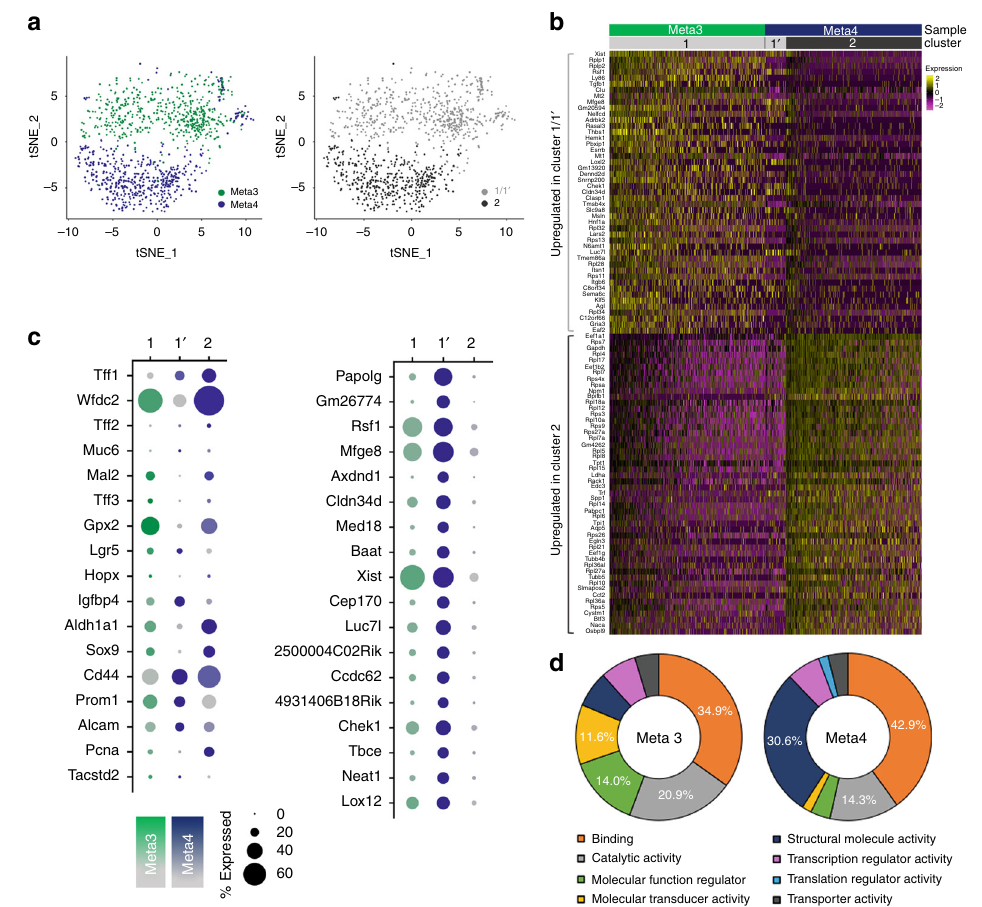
Fig. 2 Single-cell RNA sequencing analysis of Meta3 and Meta4 cells. a t-SNE plot with overlay of Meta3 and Meta4 samples (left) and clustering of Meta3 and Meta4 datasets into subpopulations 1, 1 ’ , and 2 (right). b Heatmap of the top 50 (approximately) upregulated genes found by differential expression analysis between subpopulations 1/1 ’ and 2. Upregulated genes were de fi ned as those expressed in at least 25% of the cells in the sample with at least 0.1 log fold-change over the other subpopulation. P -values were calculated using a two-tailed the Wilcoxon Rank Sum test with Bonferroni correction and were <0.05. Rows correspond to individual genes and columns are individual cells, arranged by sample and subpopulation. Yellow corresponds to high expression, black corresponds to neither high nor low expression, and purple corresponds to low expression. c Dot plots showing selected markers for GCSCs, SPEM, IM, proliferation, and normal gastric epithelium, displayed by sample and subpopulation (left). Dot plots of upregulated genes identi fi ed by differential expression analysis of subpopulations 1 ’ and 2 within only the Meta4 sample, displayed by subpopulation and sample, including both Meta3 and Meta4 (right). The dot size represents the percent of cells within the subpopulation with detected expression of the gene and color intensity re fl ects the average expression in those cells with detectable gene expression. d PANTHER gene ontology classi fi cation results using the top 50 upregulated genes from differential expression analysis between Meta3 and Meta4 samples.